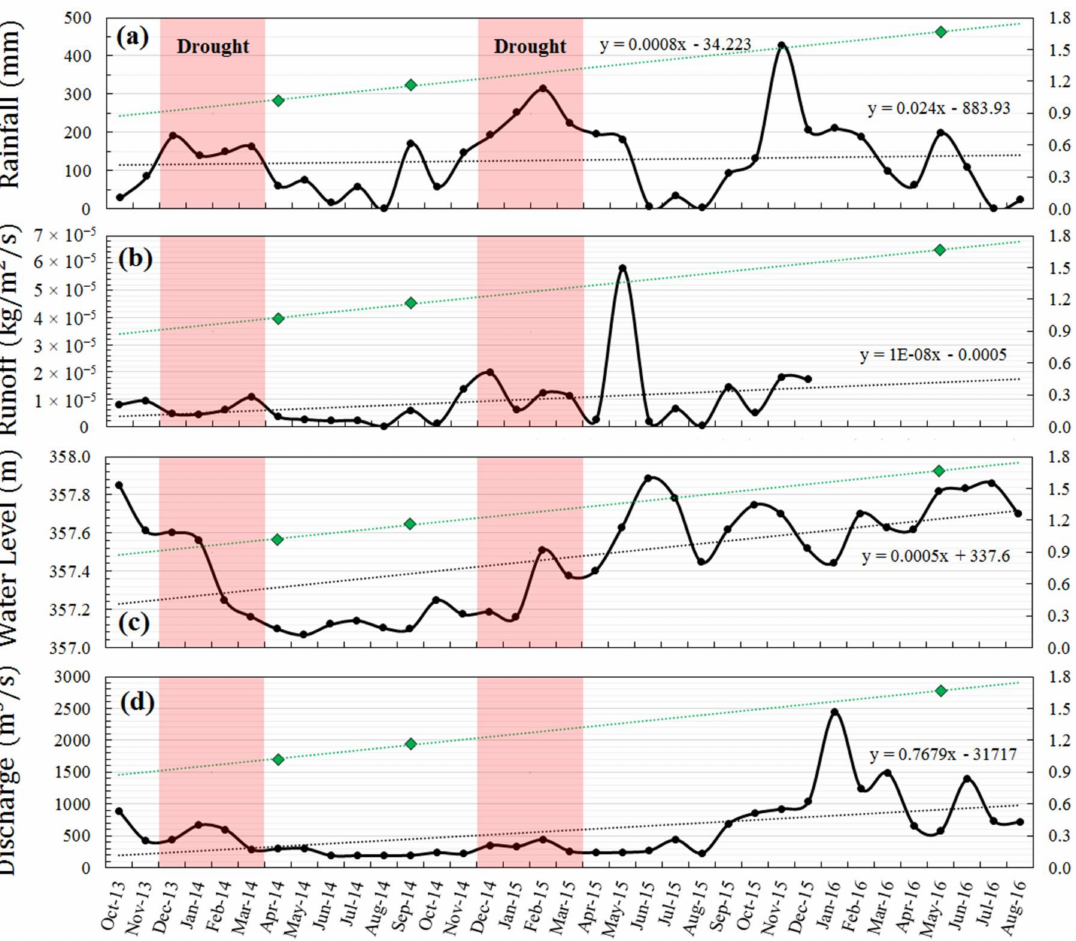
Figure 7. Temporal trends in ( a ) rainfall, ( b ) runoff, ( c ) water level, and ( d ) discharge variability from October 2013 to August 2016. The green diamonds represent a t ( 443 ) predicted by QAA OMW from the three field trips carried out in Nav during April 2014, September 2014, and May 2016. Rainfall data were acquired from NASA’s GIOVANNI database based on TRMM data with 0.25 ◦ of spatial resolution (http://giovanni.sci.gsfc.nasa.gov/giovanni/). Runoff data were also acquired through Water National Agency of Brazil via their website